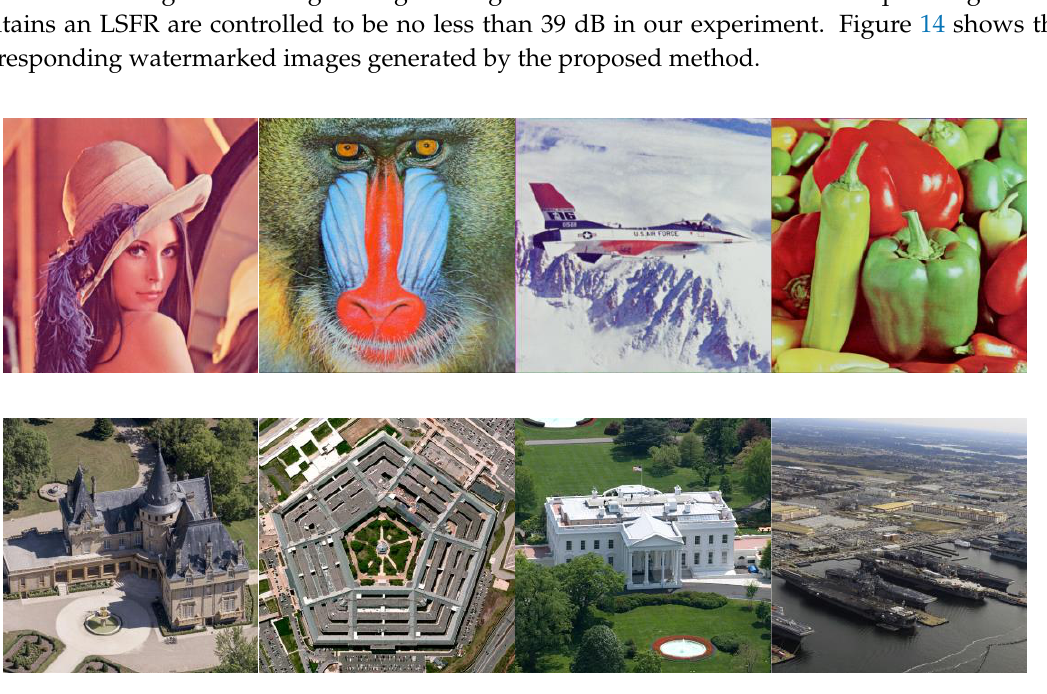
Table 2. Performance of image quality and robustness against common attacks.